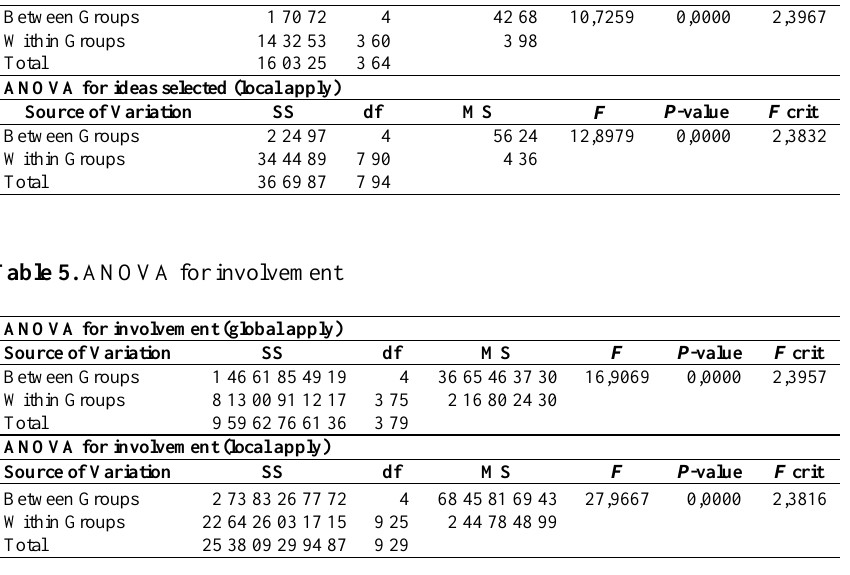
Table 4. ANOVA for ideas selected ANOVA for ideas selected (global apply) Source of Variation